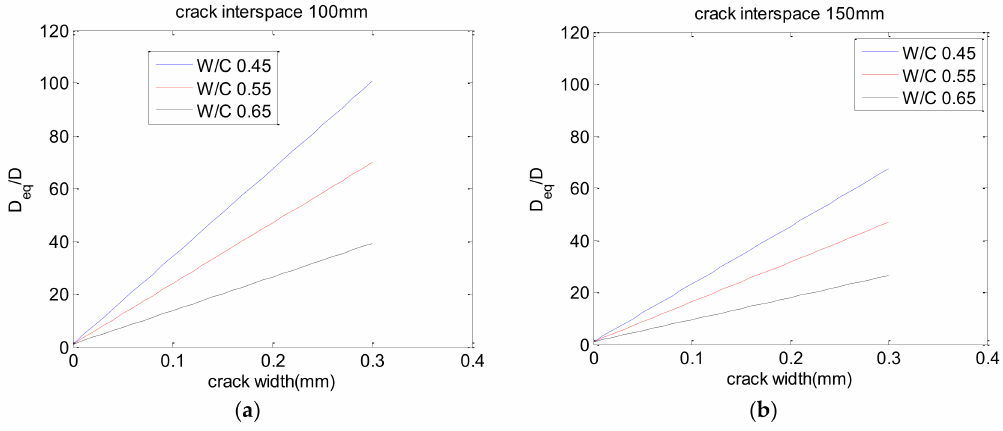
Figure 4. Ratio of D eq vs. crack width for different W/C ratios. ( a ) crack interspace 100 mm; ( b ) crack D interspace 150